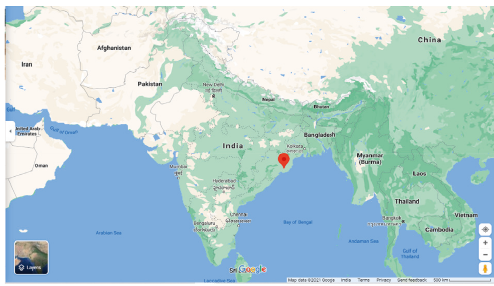
Figure 1: Google map showing Bhubaneswar smart city (red icon) of Odisha state in India [2].